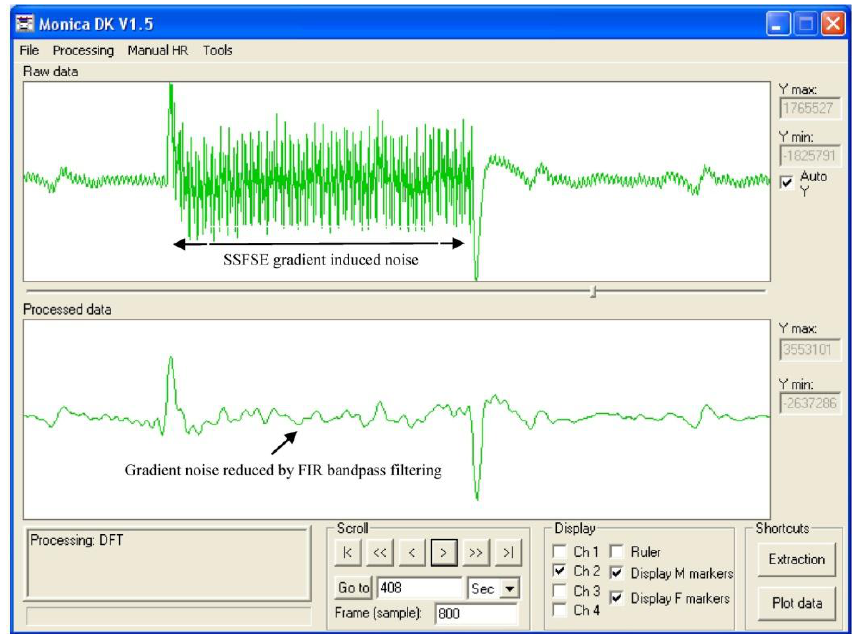
Figure 6. The effects of a single shot fast spin echo sequence gradient burst on the fECG trace (upper plot). The effects of a bandpass FIR filter are shown in the lower trace. The effects of the gradient pulses are largely removed from the trace but the phase of the ECG signal is temporarily